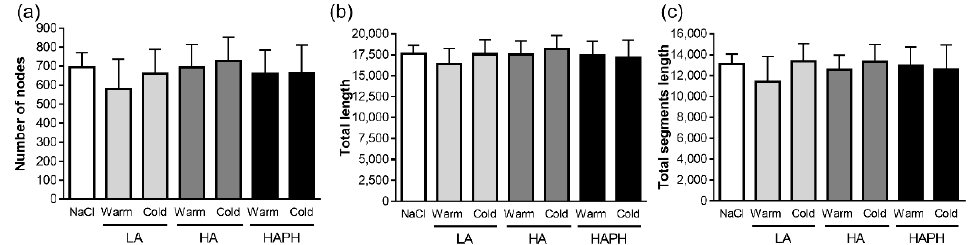
Figure 6. Effects of isolated microparticles (MPs) on human pulmonary artery endothelial cells (PAECs): angiogenesis. Human PAECs are exposed to isolated MPs and their effects on different parameters of angiogenesis ( a – c ) are presented. LA — lowlanders, HA — highlanders, HAPH — highlanders with pulmonary hypertension. Results are presented as mean ± SEM (n = 3).